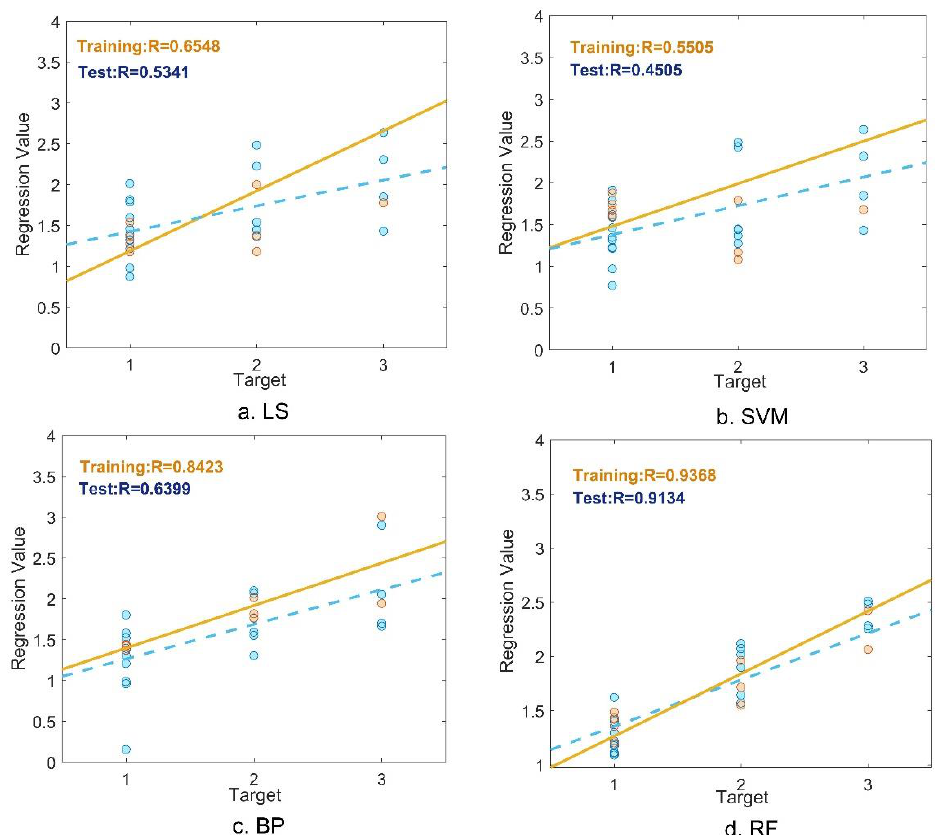
Figure 3. Modeling accuracy of DSS-LPV based on four Machine Learning methods: ( a – d ) represent regression accuracy of training and test of LS, SVM, BP, and RF models, respectively. R represents the correlation between regression value and target. The yellow points are the training set, the blue points are the test set, and the straight lines are the fitting lines.